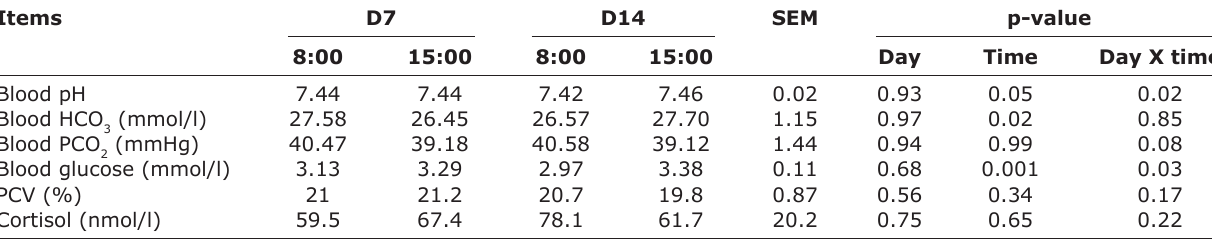
Table-3: The effect of natural HTa on blood parameters from D7 and D14.